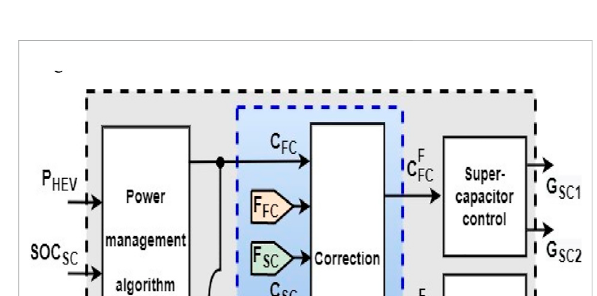
FIGURE 7 Connection of power sources to DC bus.